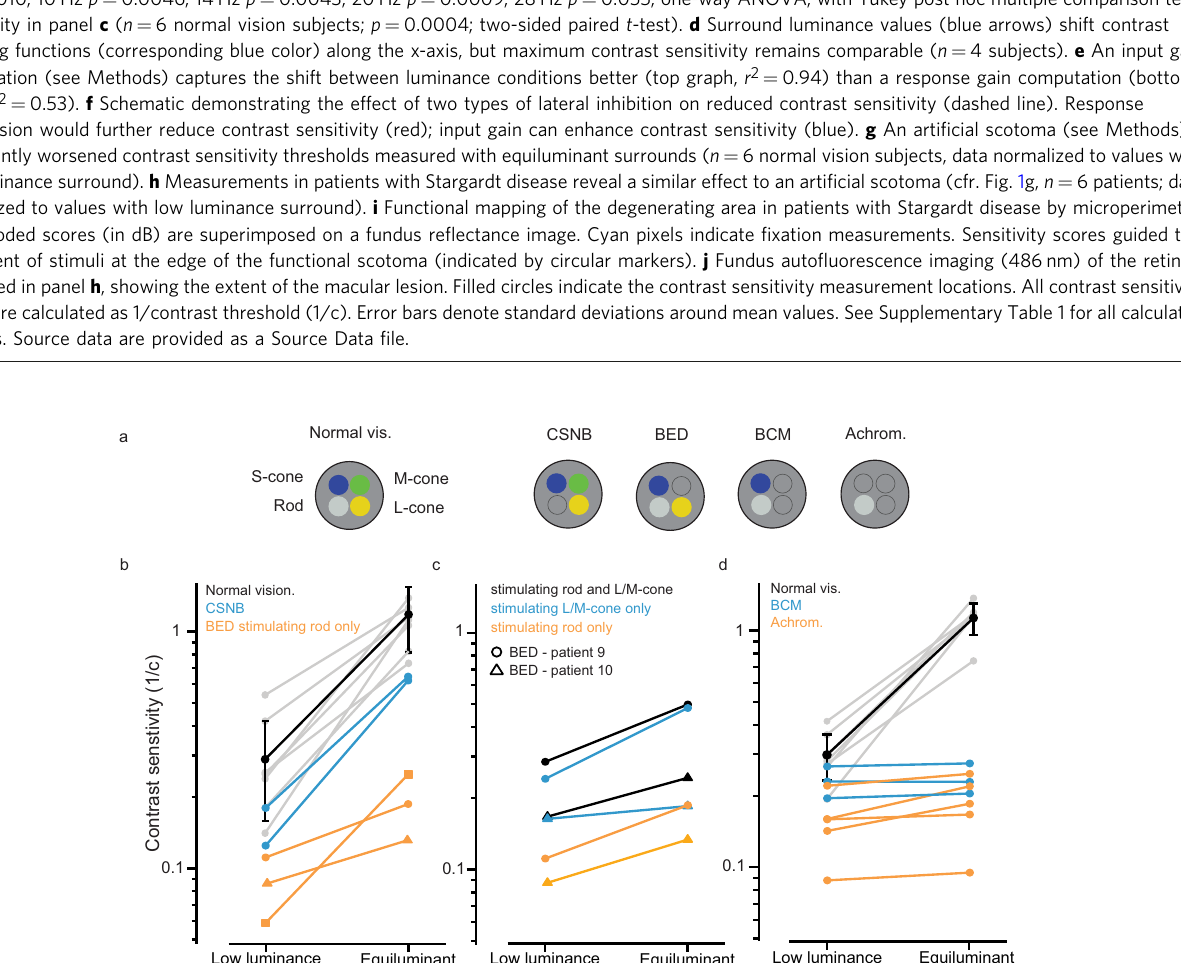
Fig. 2 Speci fi c photoreceptor mutations in patients identify the cell types involved in lateral adaptive feedback. a Schematic showing the contributing photoreceptor types in normal vision subjects, congenital stationary night blindness (CSNB, cone-only vision), Bornholm eye disease (BED, lack of one cone opsin; M-opsin for two of three patients tested, L-opsin for one patient) blue cone monochromatism (BCM, rod, and S-cone vision), achromatopsia (rod- only vision). b Selective stimulation of rod photoreceptors in two BED patients ( n = 2 patients; orange traces) or cone photoreceptors in two CSNB patients ( n = 2 patients; blue traces) showed a positive rather than suppressive effect. Comparative data for normal vision subjects is shown in black ( n = 8 subjects, data also shown in Fig. 1b). c An equiluminant surround improved vision in two Bornholm eye disease patients using rod isolating (orange traces), cone isolating (blue traces), and rod-cone stimuli (black traces). d An equiluminant surround provided only a marginal improvement over a mismatched surround in patients with achromatopsia ( n = 5 patients, orange traces) and blue cone monochromatism ( n = 3 patients, blue traces), indicating an essential role for L/M cone photoreceptors in driving the effect. All contrast sensitivity values are calculated as 1/contrast threshold (1/c). Error bars denote standard deviations around mean values. Source data are provided as a Source Data fi